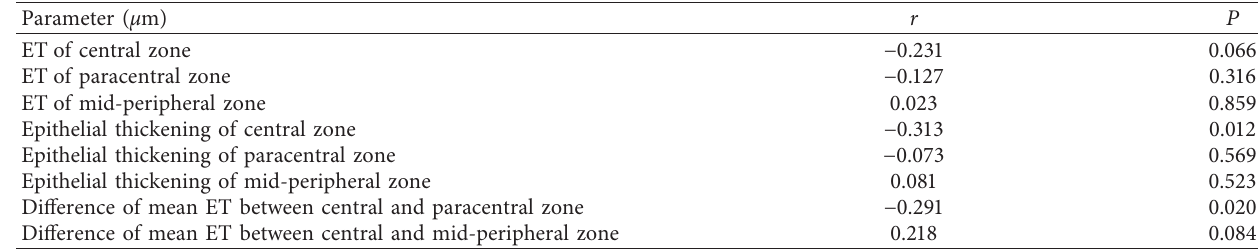
Table 5: Correlation between spherical equivalent and corneal epithelial thickness parameters at six months postoperatively. Parameter ( μ m) ET of central